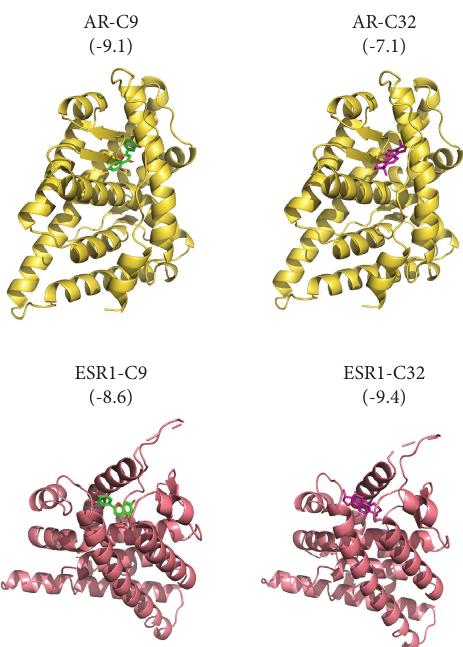
Figure 8: Results of molecular